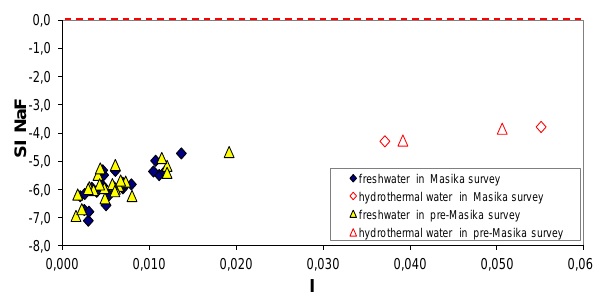
Fig. 16. Plot of villiaumite saturation index vs. ionic